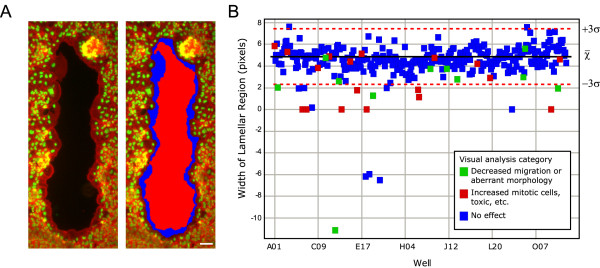
Automated analysis of wound healing images. (A) An image showing normal migration and the same image after automated analysis defines regions. Extracting characteristics of the lamellar region (blue) allows us to distinguish between the phenotypes that affect wound healing (Figure 1). Stains: red – filamentous actin; green – DNA. Bar 100 μm. (B) Automated and visual analysis are complementary approaches. Automatically generated lamellar width data is plotted for a 384 well plate. Compounds found to affect wound healing by visual analysis are shown in green, and wells that differed from the control in other ways (increased mitotics, a disrupted monolayer, etc.) are shown in red. Mean lamellar width (black line) and three standard deviations (red dashed lines) are plotted for control wells. Data collected from screening one 384 well plate of small molecules.